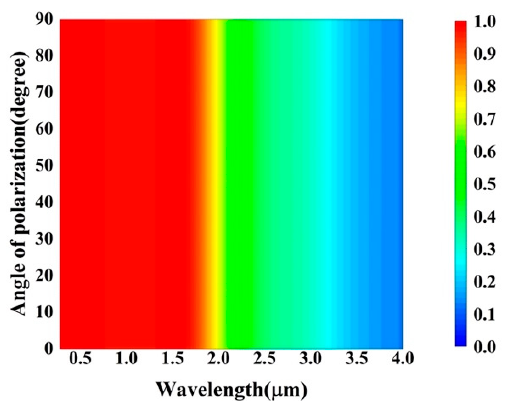
Figure 7. ( a ) The effect of periods ( P ) on the absorptance of the meta-structure absorber. ( b ) Absorp- tance spectra comparison of the simple W film, MIM structure, pure W truncated cone absorber and meta-structure absorber.